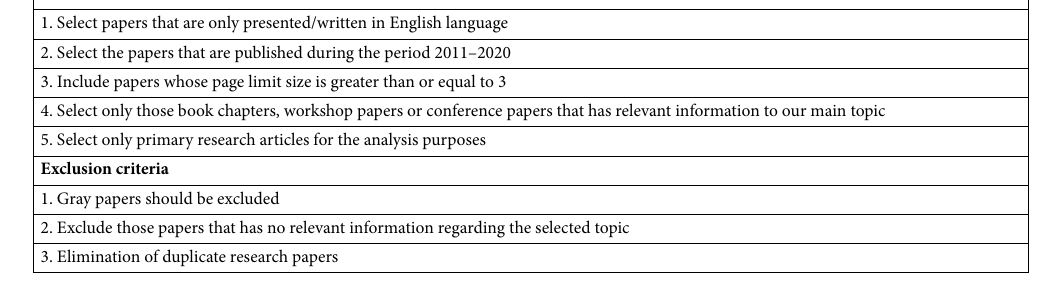
Table 4. Inclusion of exclusion criteria.